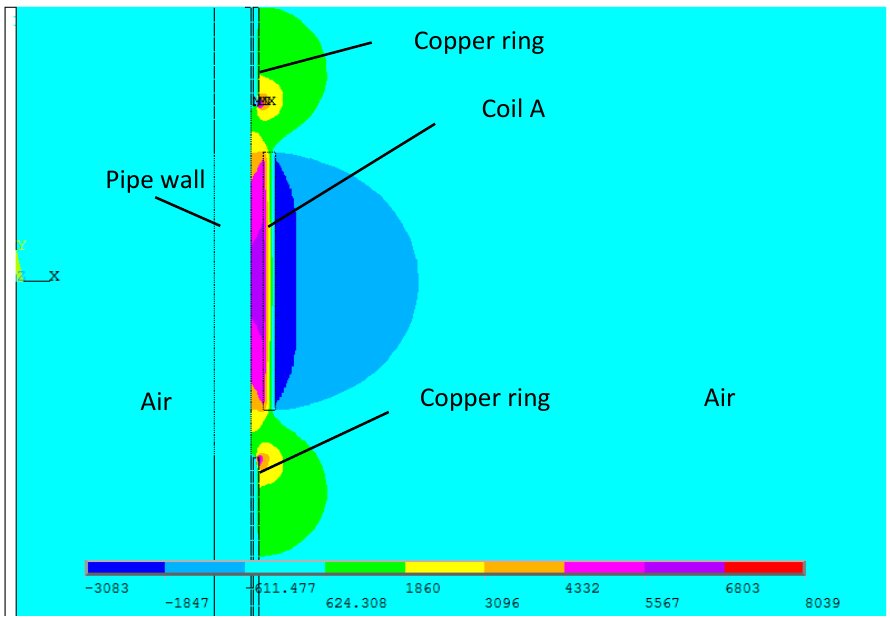
Figure 8. The alternating magnetic field produced by the special structure when L = 30